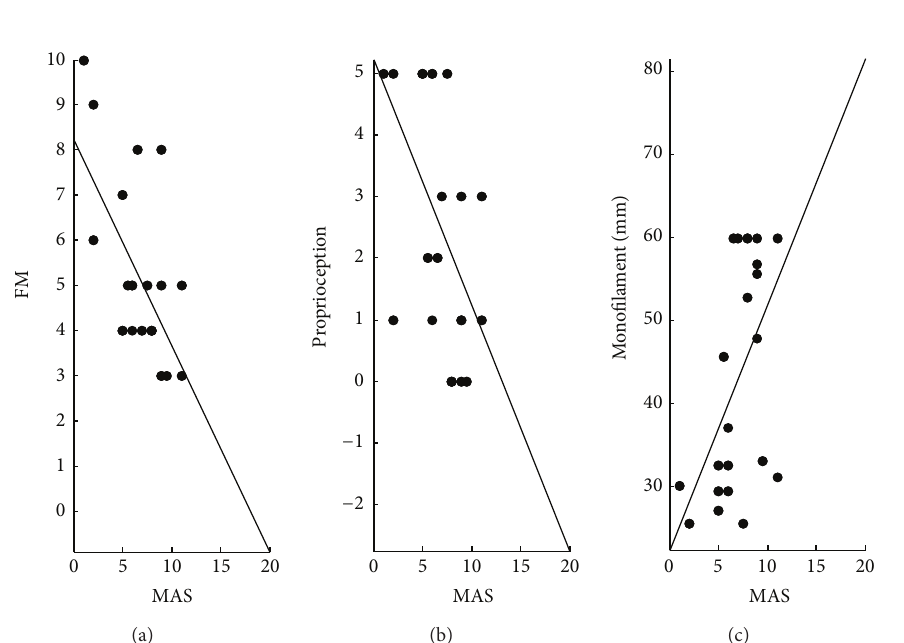
Figure 2: At baseline, greater spasticity according to summated upper limb MAS scores correlated with poorer skilled motor function and greater sensory deficits (MAS—Modified Ashworth Scale; FM—Fugl-Meyer for upper